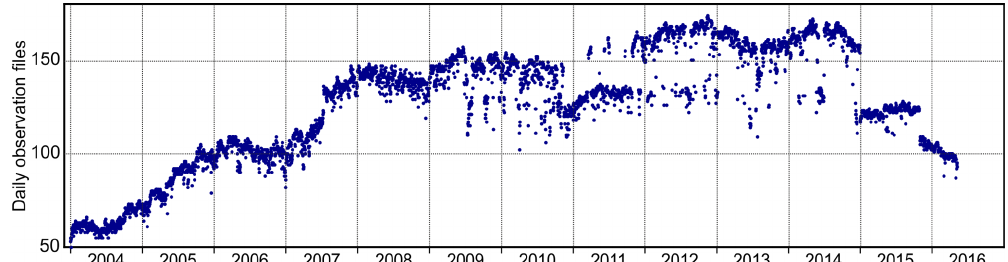
Figure 3. Amount of daily observation files processed in this